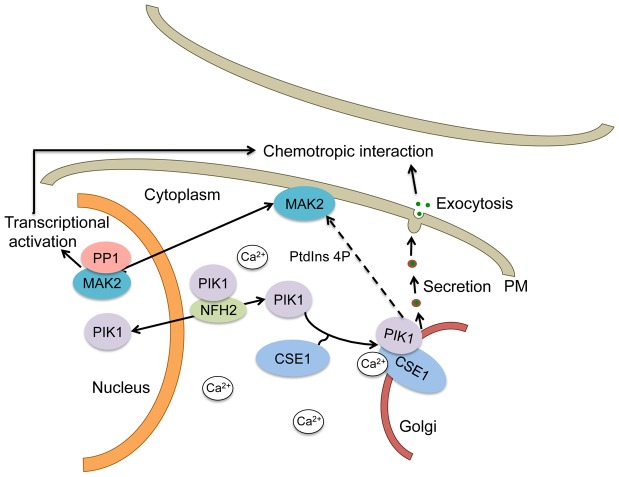
Schematic of a mechanistic model for the regulation of secretion by CSE1, PIK1 and NFH2 during germling chemotropic interactions and cell fusion.PIK1 interaction with CSE1 allows its recruitment to Golgi membranes, where it plays a role in PtdIns4p production and the regulated secretion of the signals needed for chemotropic interactions. In addition, PtdIns4p may play a role in MAK2 activation, which is required for chemotropic interactions and cell fusion. PIK1 is predicted to shuttle between the cytosol and the nucleus in a manner that is dependent on the BMH1 homolog NFH2.